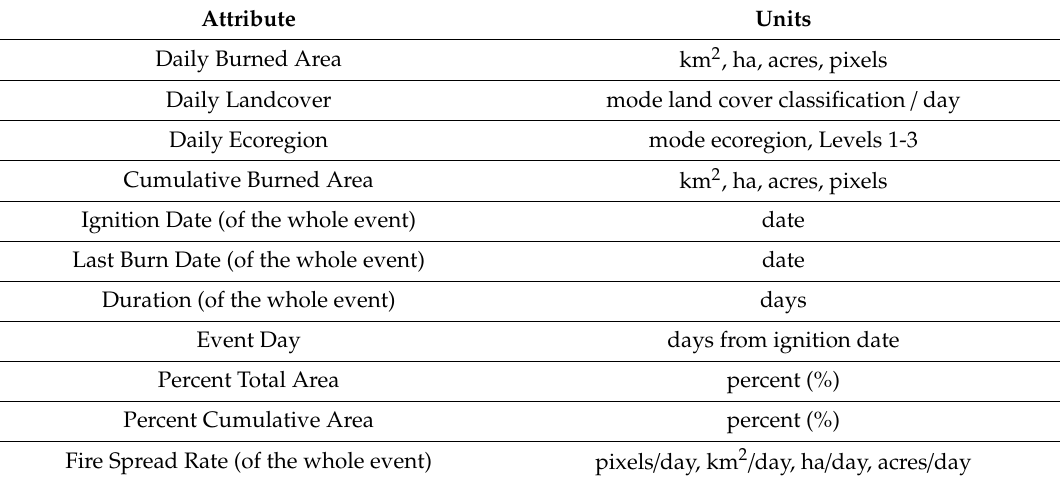
Table 4. Attributes included in the daily-level FIRED